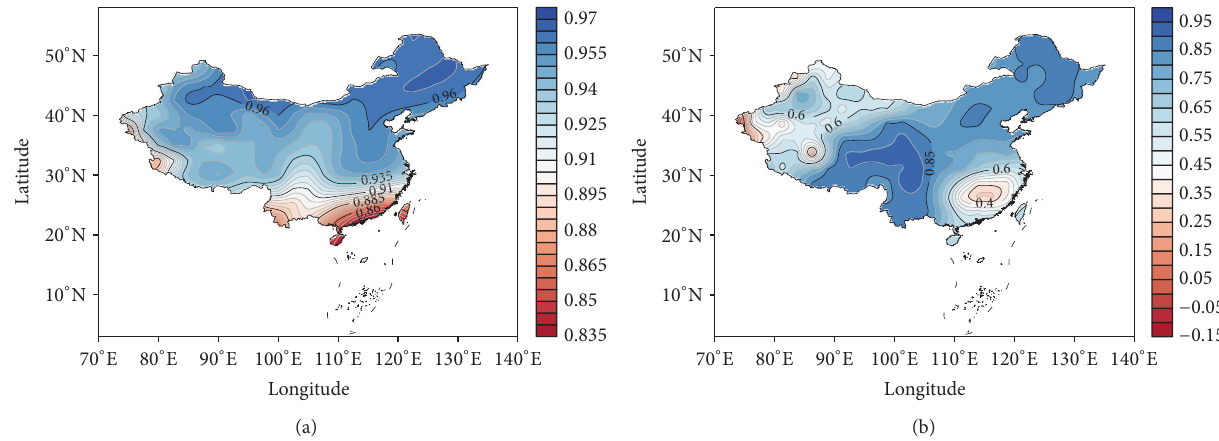
Figure 10: The SVD distributions of PW and precipitation in China: (a) distribution of anisotropic correlation coefficients for the right field of the first model and (b) distribution of anisotropic correlation coefficients for the left field of the first model.